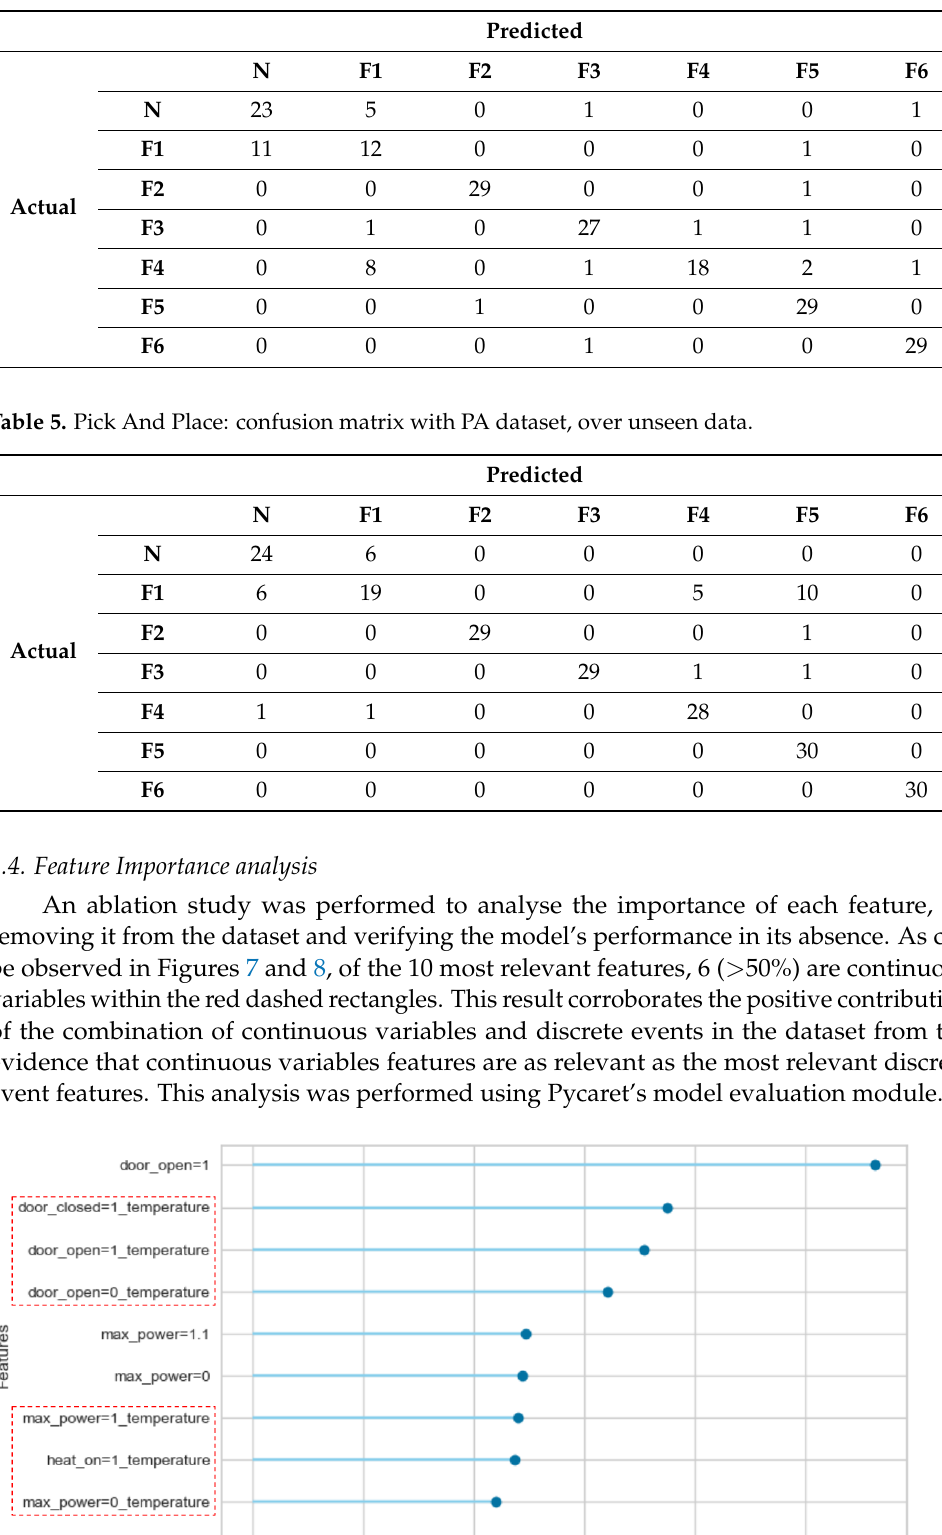
Table 4. Pick And Place: confusion matrix with ODE dataset, over unseen data.